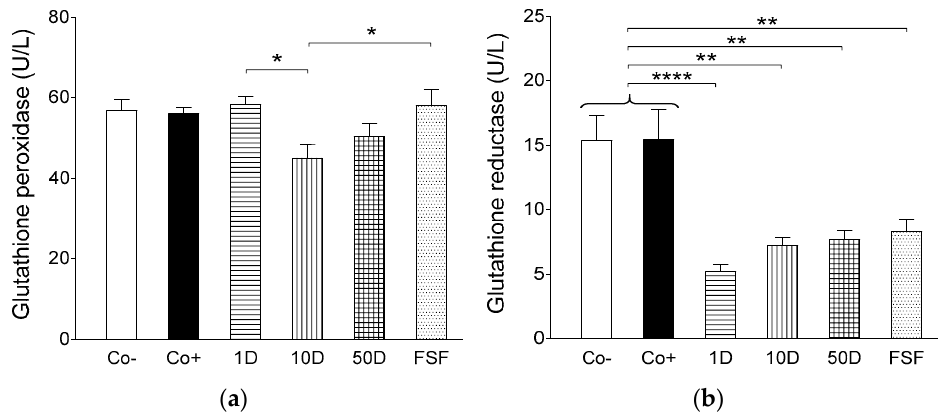
Figure 5. The effect of high-fat, high-sugar diet (HFHSD) (positive control: Co+), 2 g/kg bw/day fenugreek seed flour in addition to HFHSD (FSF), 1, 10 and 50 mg/kg bw/day diosgenin in addition to HFHSD (1D, 10D and 50D, respectively) on plasma activities of two major glutathione-handling enzymes, glutathione peroxidase ( a ) and glutathione reductase ( b ), in Wistar rats. The negative control group (Co − ) consisted of rats receiving conventional diet. The columns represent the average values of the given groups (+SEM). Asterisks indicate the significance level of differences between groups (*: p <0.05; **: p < 0.01; ****: p < 0.0001). In summary, diosgenin (and maybe some other components of fenugreek seed) appear(s) to